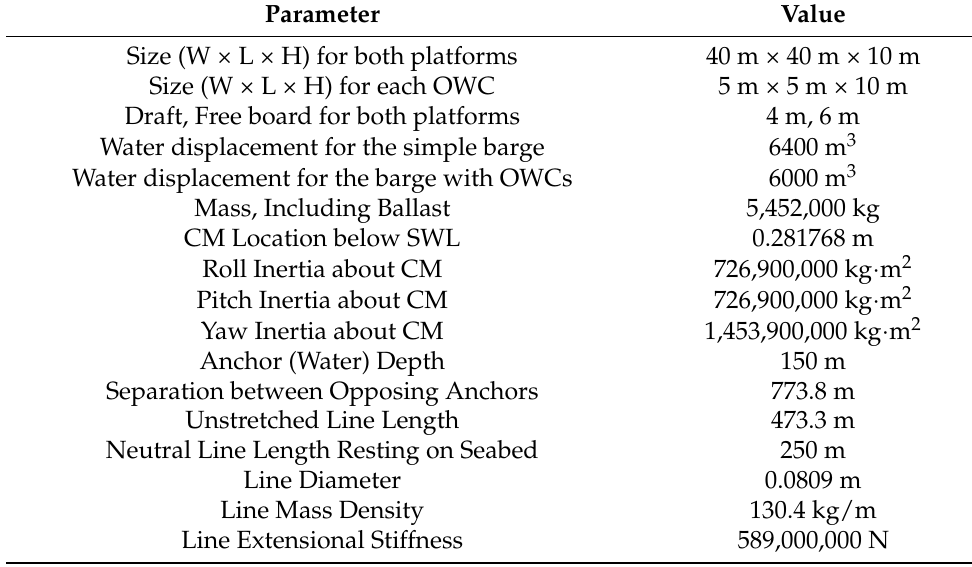
Table 1. Characteristics of the standard barge platform and the 4OWC-based barge